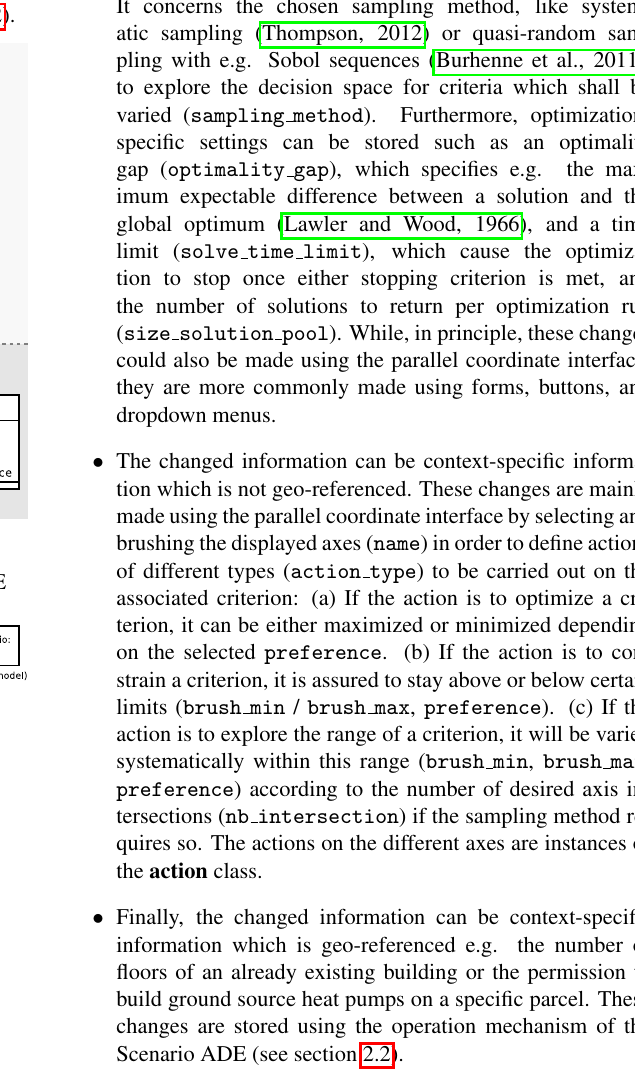
Figure 3. Flowchart of the interactive optimization workflow (dashed lines indicate alternative paths of the